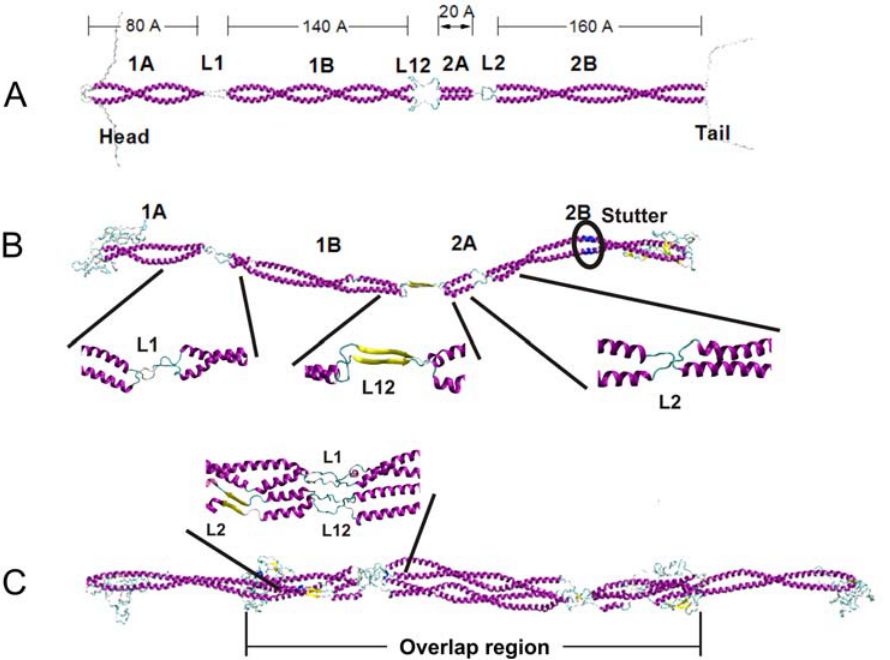
Figure 2. Molecular structures of vimentin dimer and tetramer (schematic and results of molecular simulation). Panel A: Schematic geometry of the dimer geometry, including labels identifying the various segments and linker domains. Panel B: Snapshot of the atomistic model of the dimer. The blue part denotes the stutter part around the stutter (amino acids 345–351). Panel C: Snapshot of the atomistic model of the tetramer. The blow-ups in panels B and C show detailed views of the molecular structure in the dimer and tetramer.